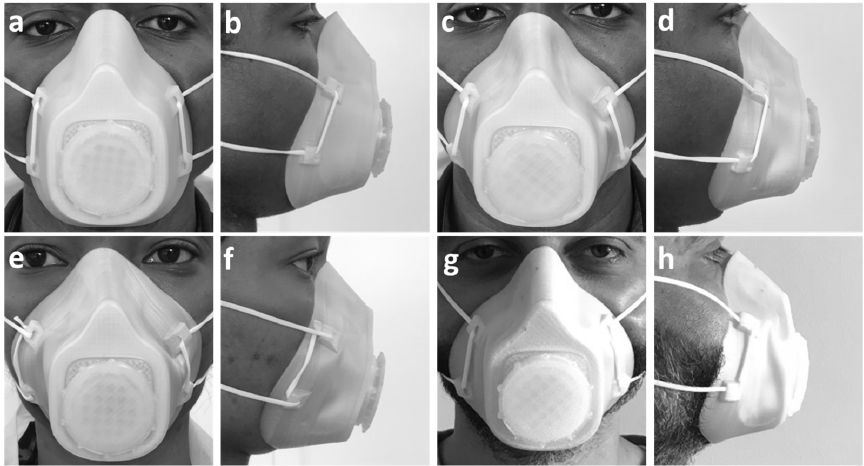
Figure 8. Mask fitting: ( a , b ) Front and side view of original mask on first fitter; ( c , d ) front and side view of molded mask on first fitter; ( e , f ) front and side view of molded mask on second fitter; ( g , h ) front and side view of molded mask on third fitter [30]. Table 5. Mask dimensions before and after molding to various fitters [30].